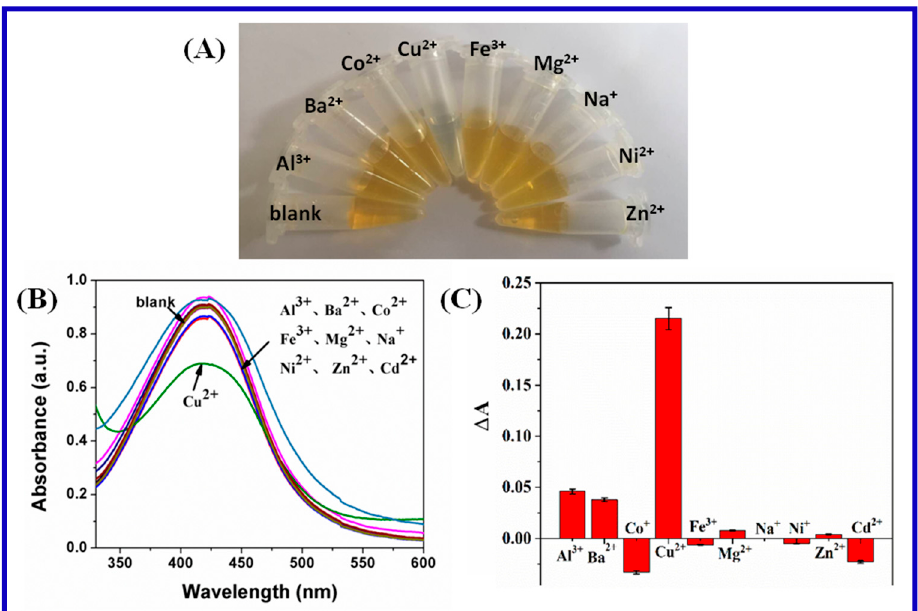
Figure 5. ( A ) Photographic image of color changes of carrageenan-AgNPs after the addition of different metal ions. ( B ) The UV-Vis absorption spectral of carrageenan-AgNPs with different metal ions. ( C ) Relative absorption intensity changes at 420 nm with various metal ions.